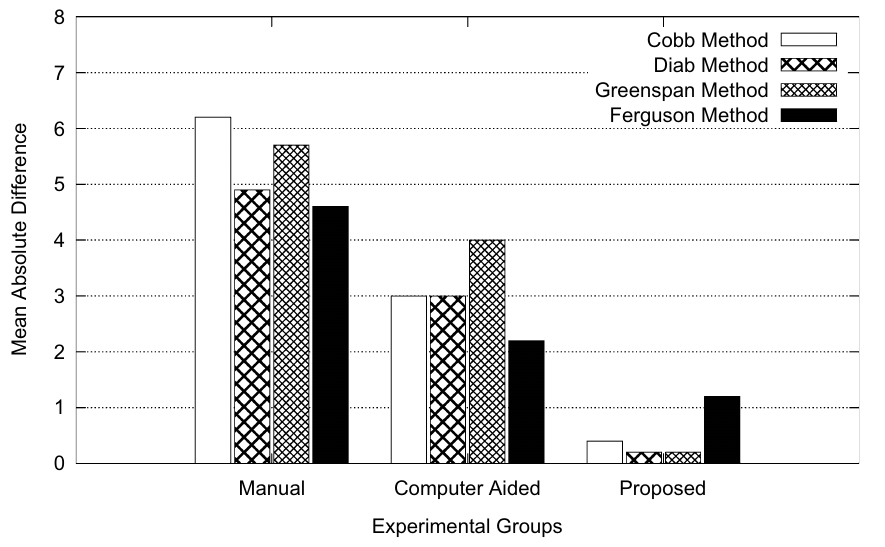
Figure 9. Type V (a) mean absolute difference (MAD) in inter observer